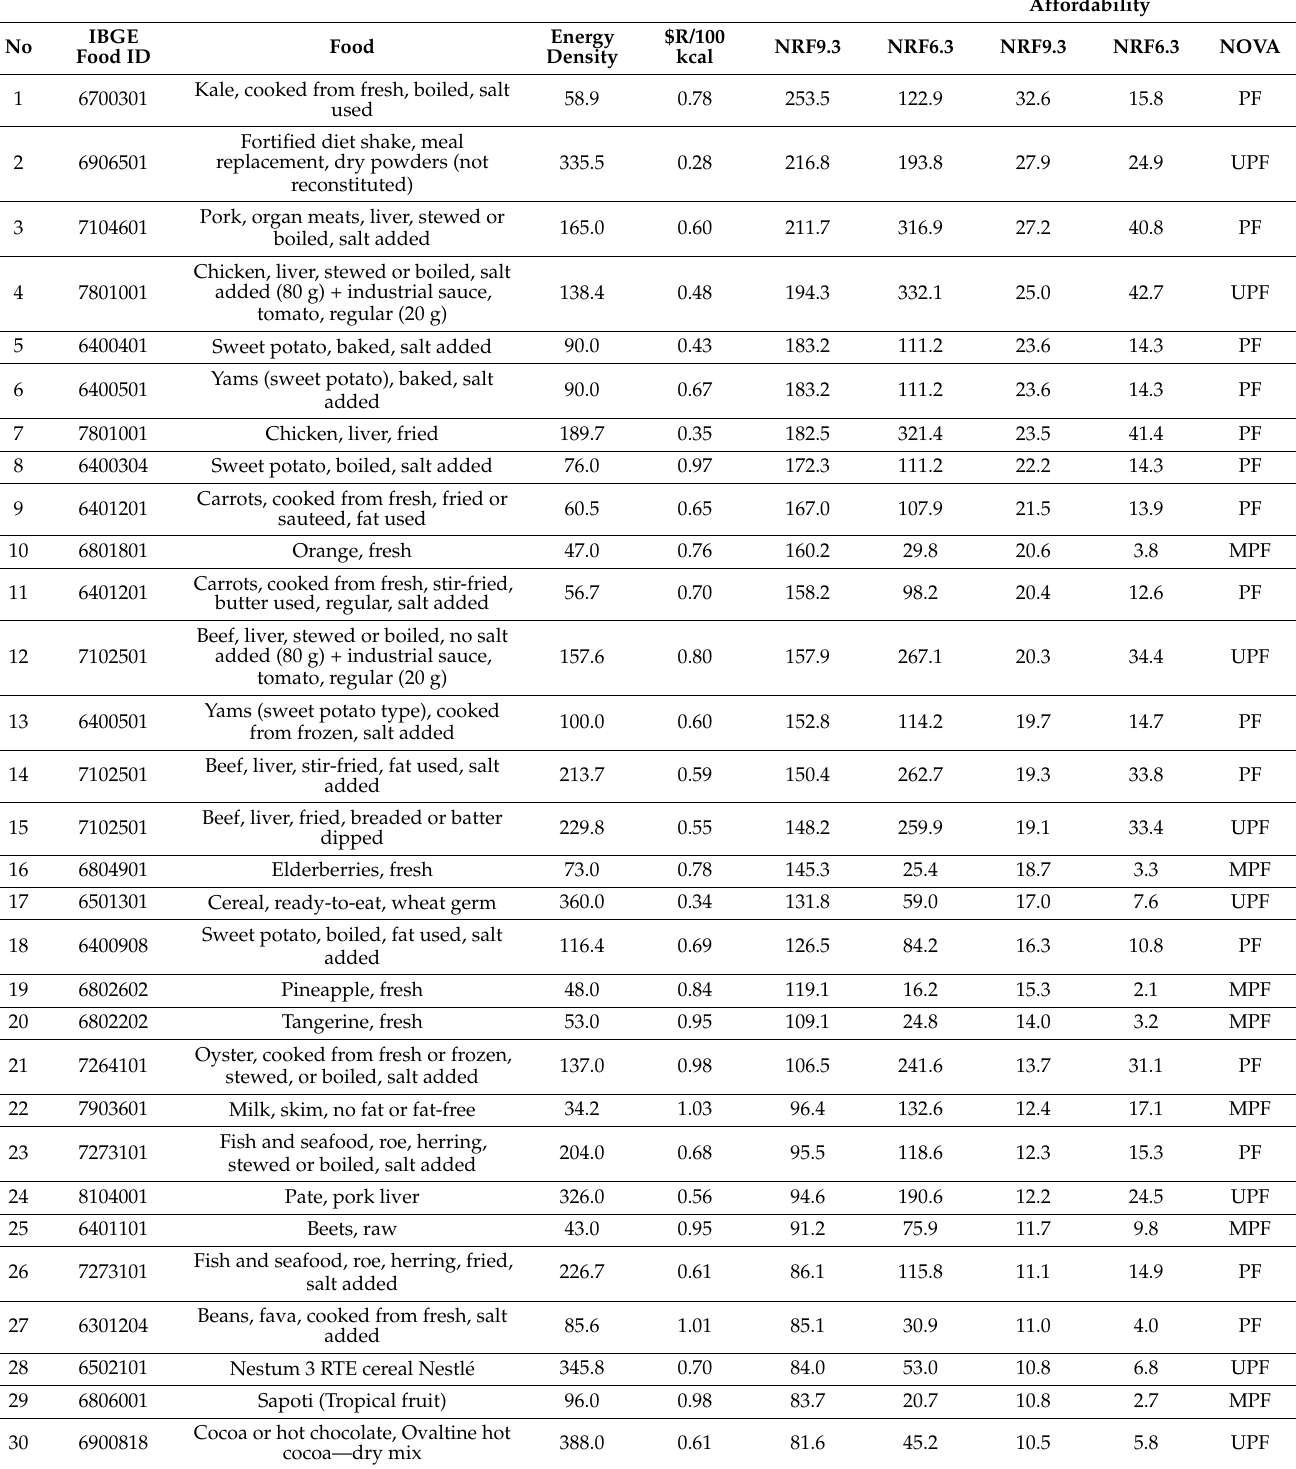
Table 3. Ranking of nutrient-rich foods in the top quartile of nutrient density scores and below the median cost per 100 kcal in